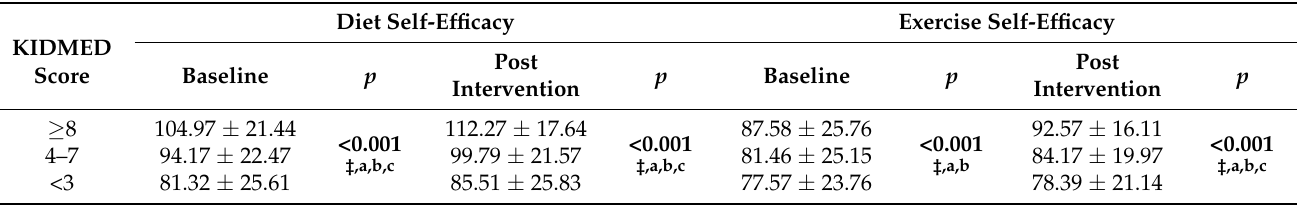
Table 3. Diet and exercise self-efficacy according to KIDMED scores, at baseline (pre-) and post-